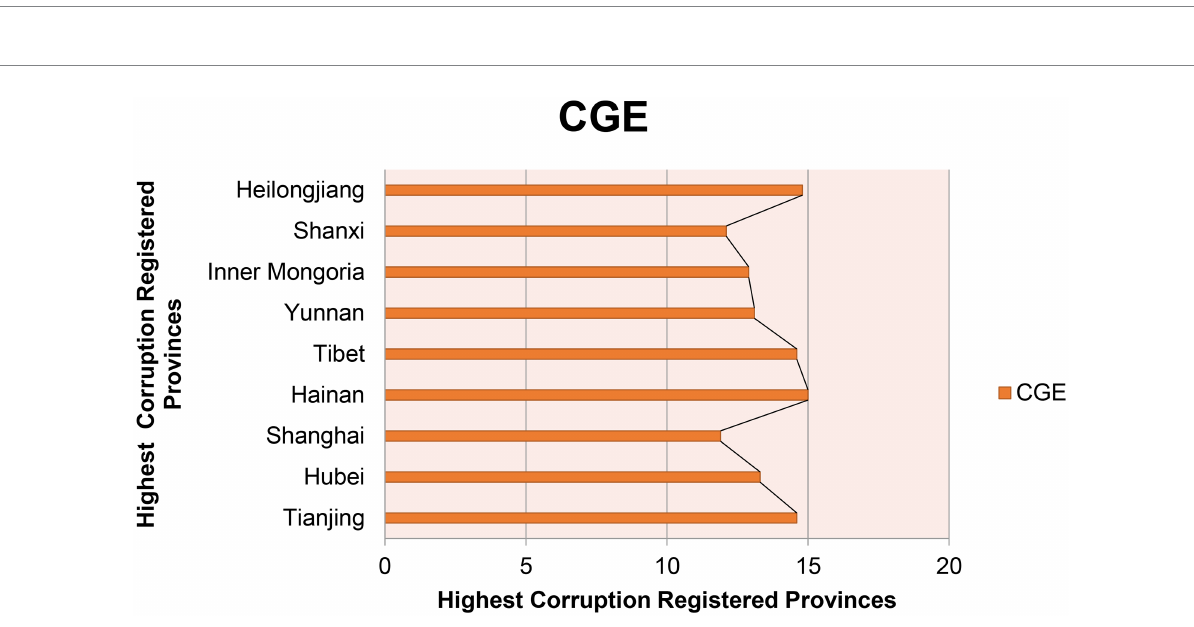
FIGURE 4 High corruption registered